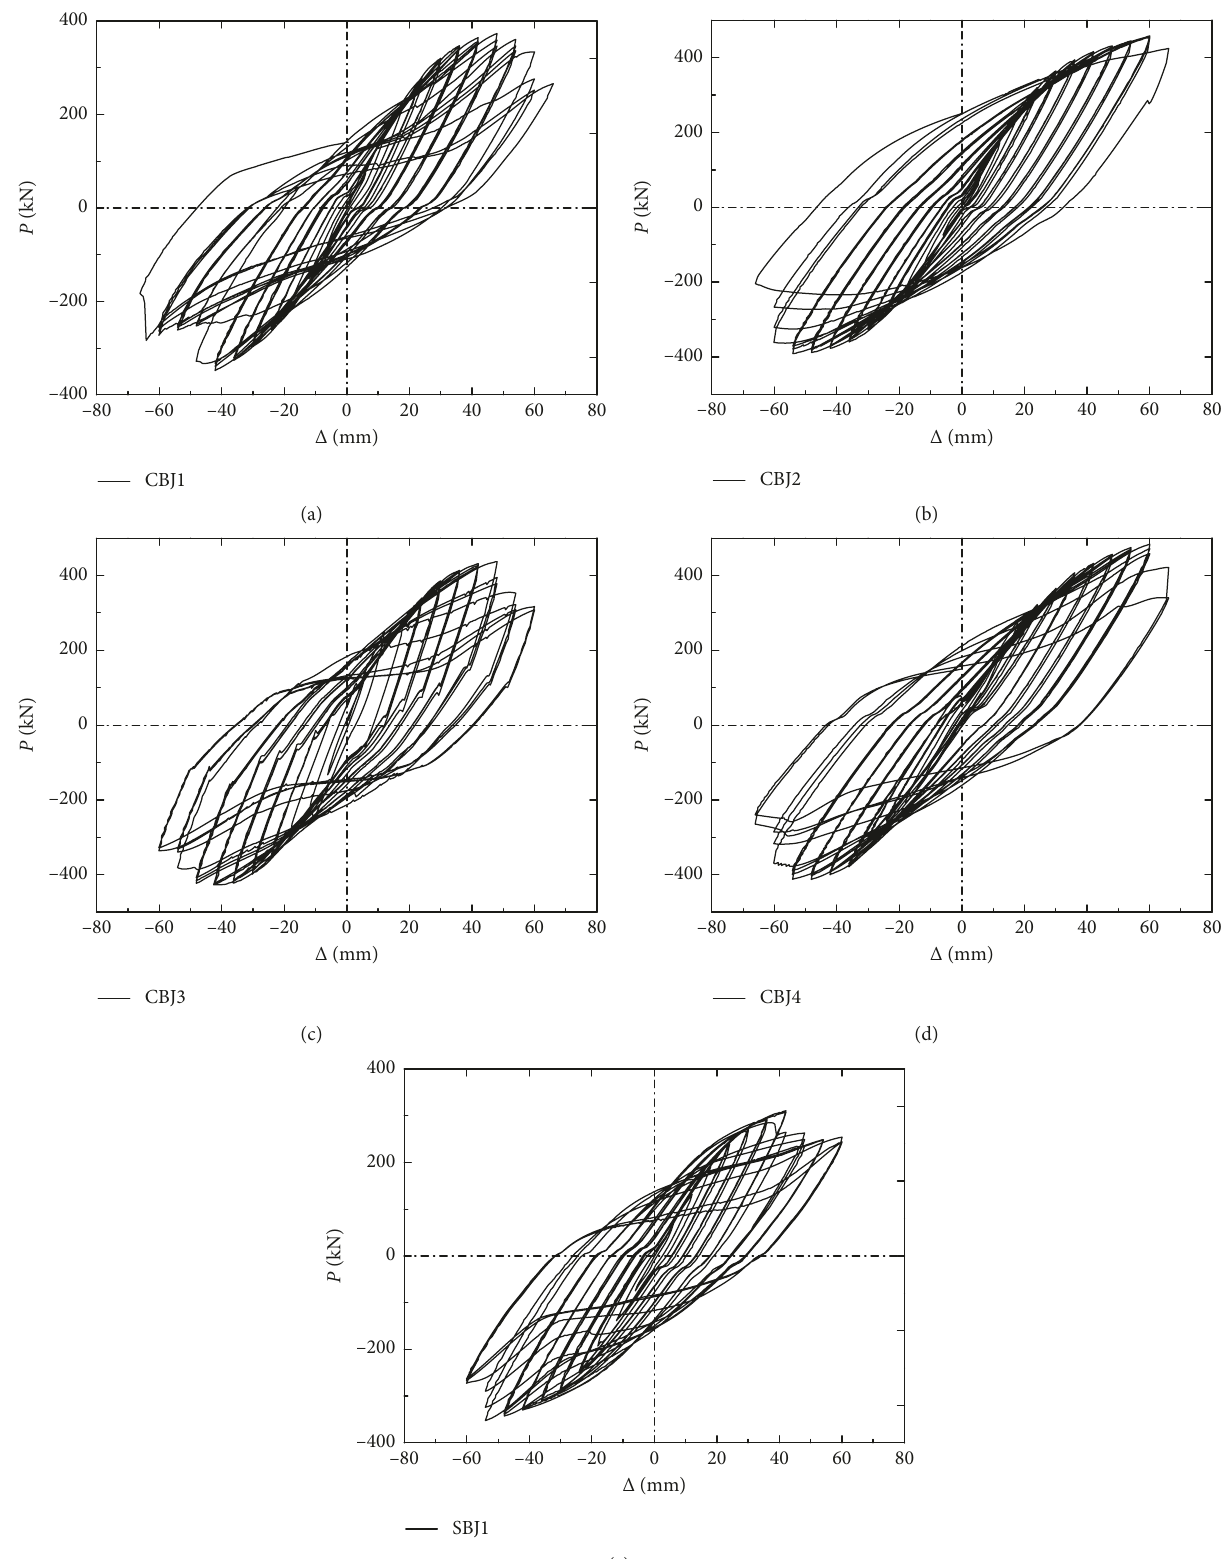
Figure 14: P - hysteresis loops of the end of the column: (a) CBJ1; (b) CBJ2; (c) CBJ3; (d) CBJ4; (e) Δ